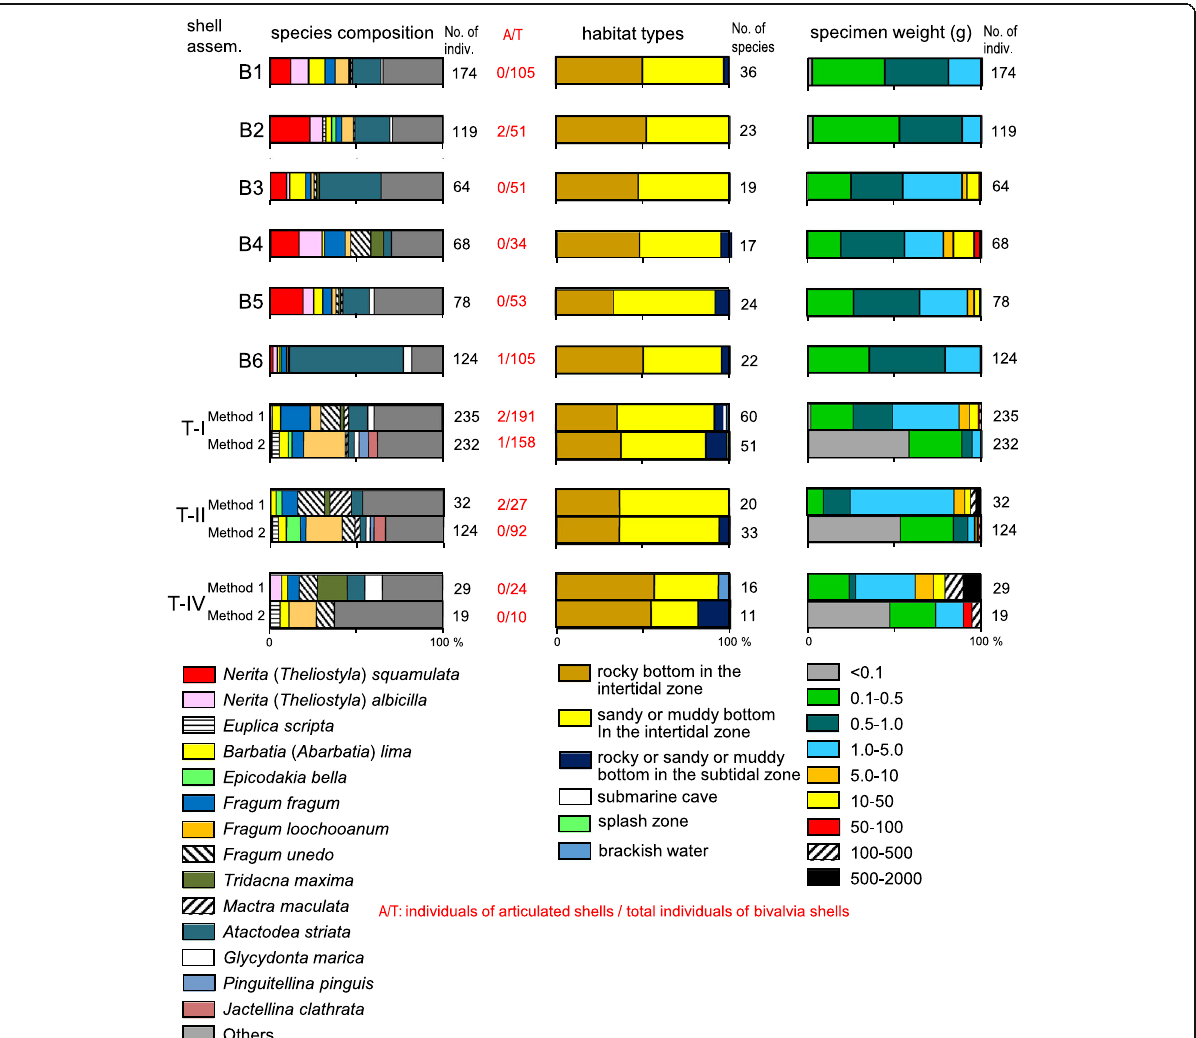
Fig. 4 Species compositions, percentage of articulated bivalve shells, habitat types, and shell weights of molluscan assemblages from recent and tsunami